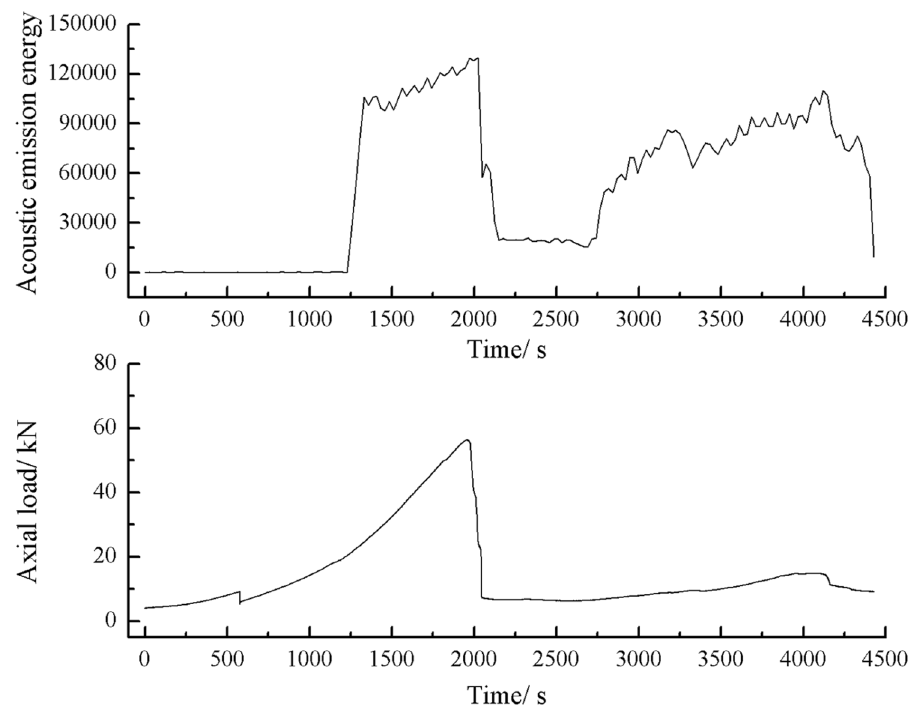
Figure 44. Acoustic emission energy-Axial load of the specimen with 2 cm